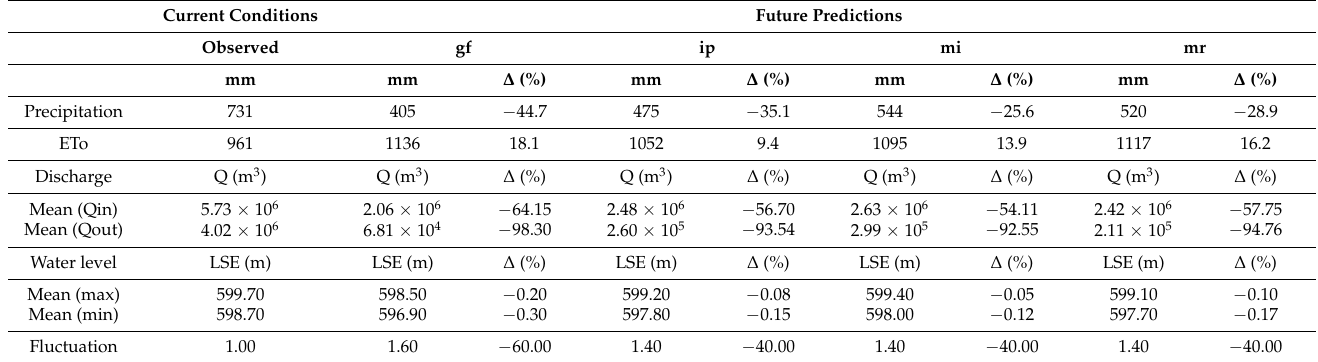
Table 5. Comparison of Lake Zazari water balance components assessed by MIKE SHE/MIKE 11